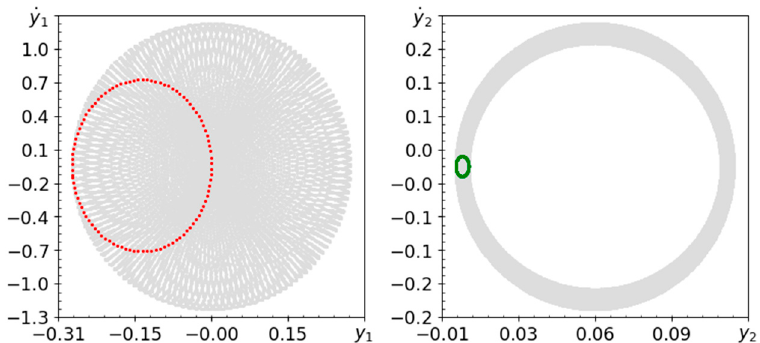
Figure 17. Phase planes and Poincar é maps for A = 0.001, ω = 7.24. Figure 17. Phase planes and Poincaré maps for (cid:1827) = 0.001 , (cid:2033) = 7.24 . Figure 17. Phase planes and Poincaré maps for (cid:1827) = 0.001 , (cid:2033) = 7.24 . Figure 17. Phase planes and Poincaré maps for (cid:1827) = 0.001 , (cid:2033) = 7.24 . Table 6. Spectra of Lyapunov exponents for the second mutation of the system with rigid pendulum. Table 6. Spectra of Lyapunov exponents for the second mutation of the system with rigid pendulum. Table 6. Spectra of Lyapunov exponents for the second mutation of the system with rigid pendulum. Table 6. Spectra of Lyapunov exponents for the second mutation of the system with rigid pendulum. Parameters Parameters Parameters